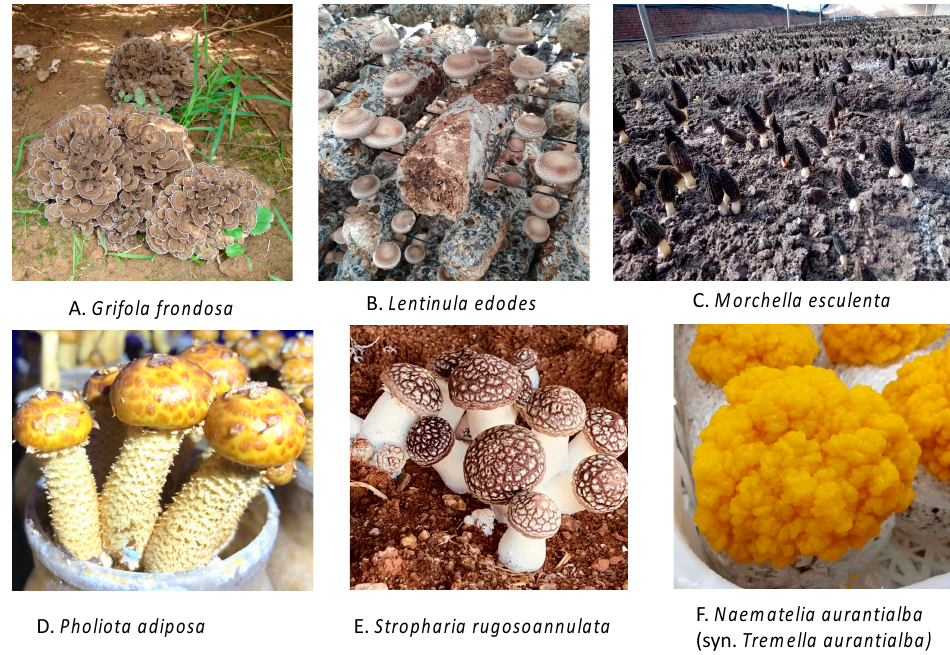
Figure 2. A few representative cultivated medicinal mushrooms.